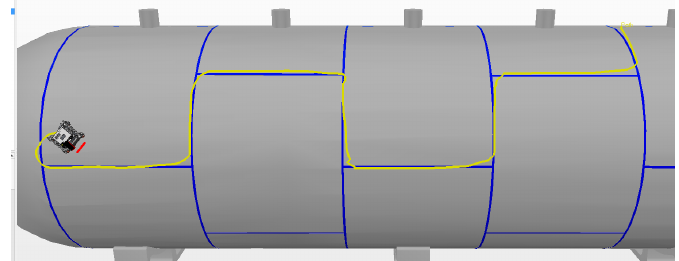
Figure 21. The experiment was performed in shared mode with 50% of the velocity controlled by the operator and 50% by the robot.